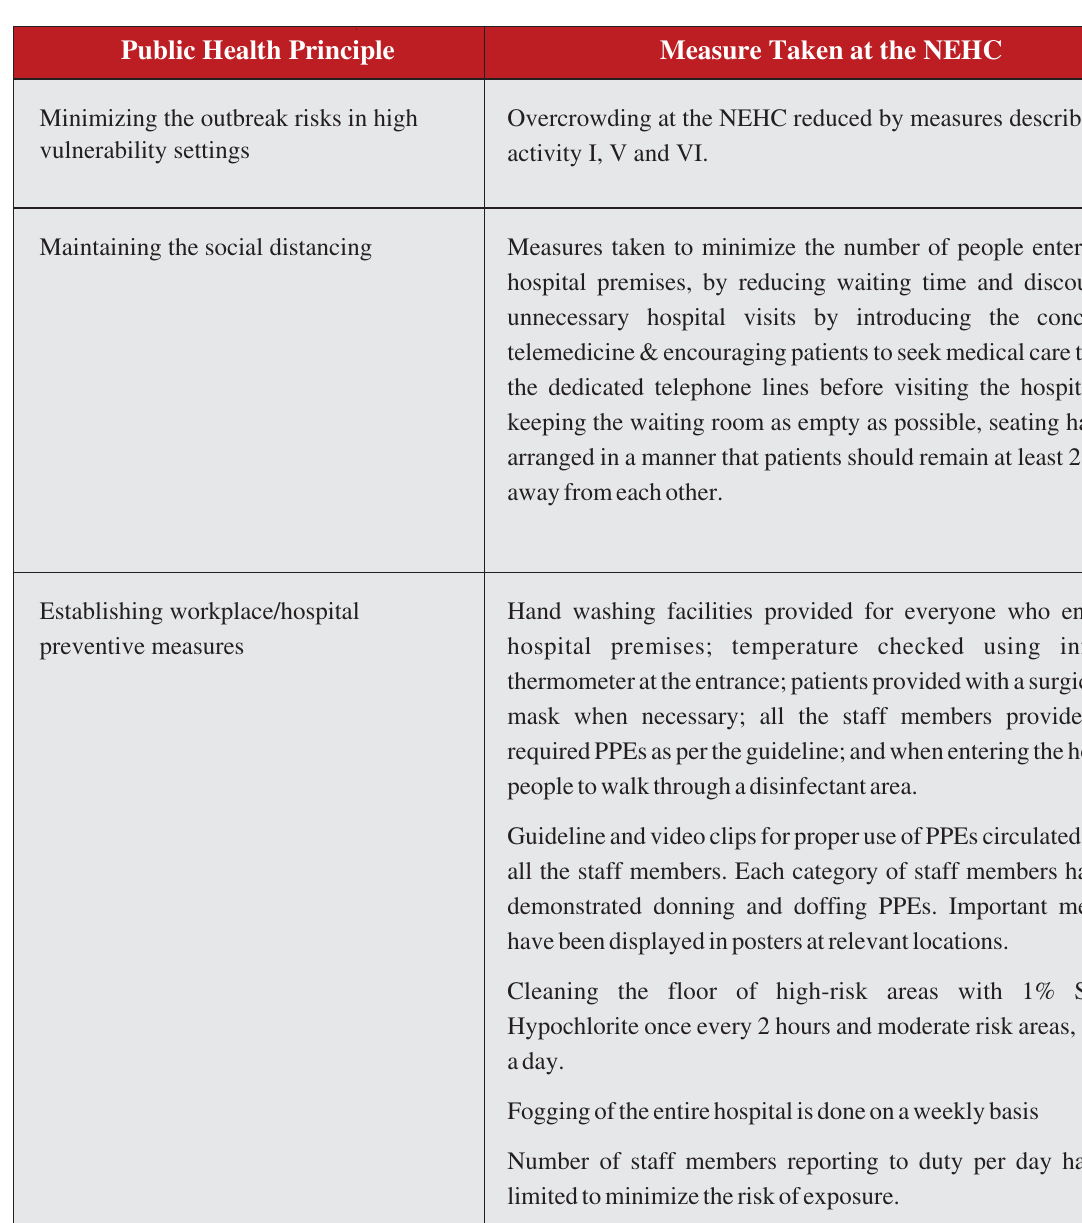
Table 2: Public health principles involved in preventing COVID-19 spread at the